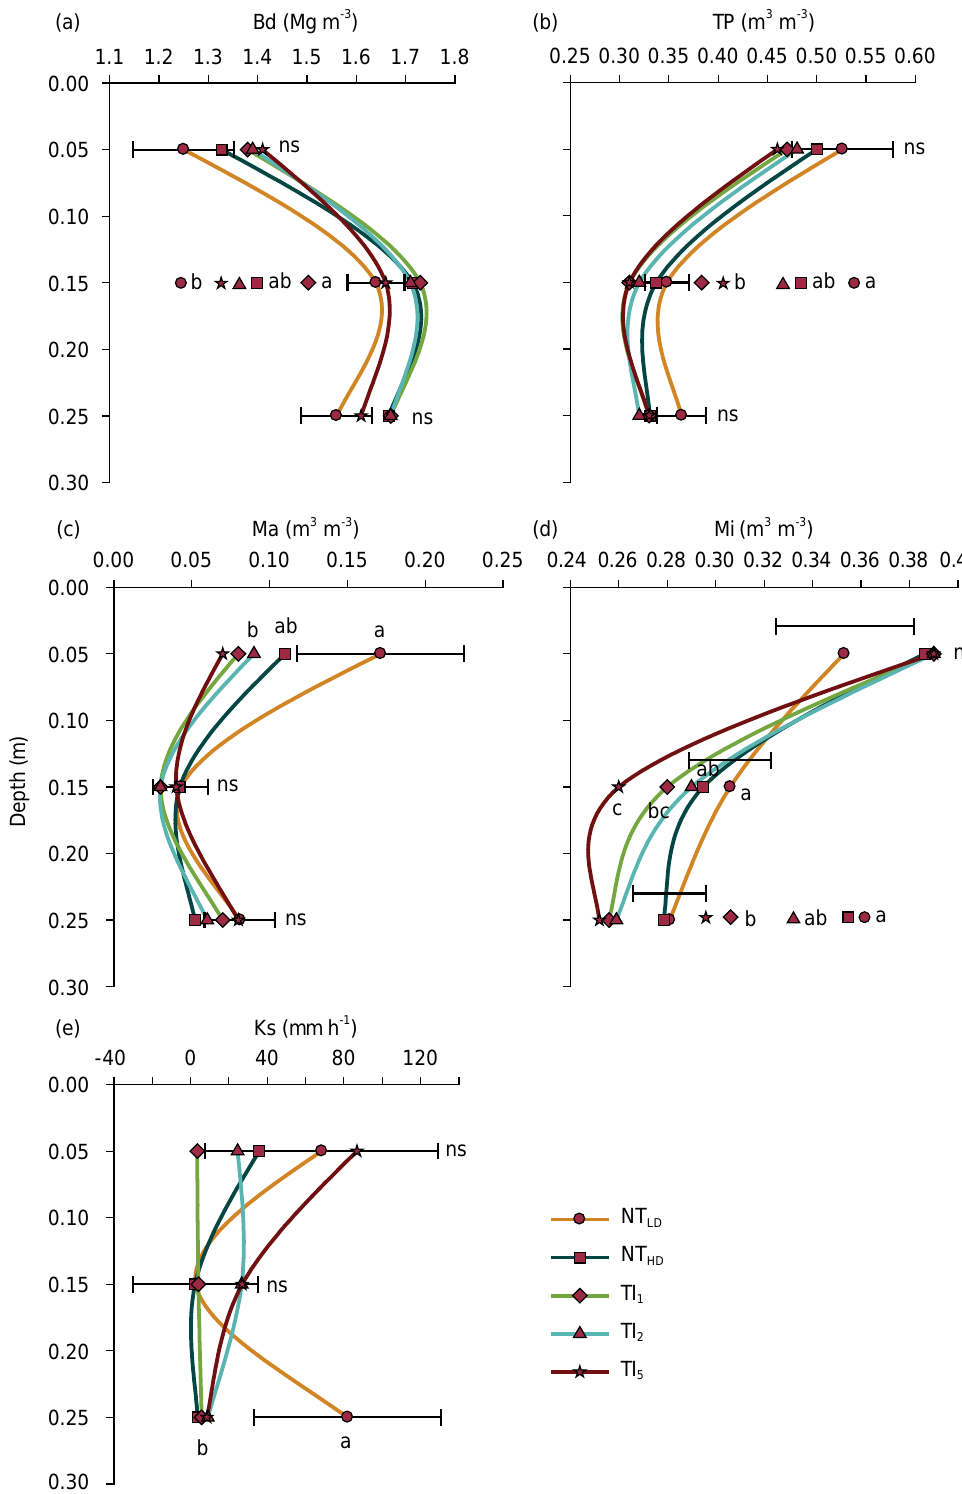
Figure 5. Soil bulk density (Bd) (a), total porosity (TP) (b), macroporosity (Ma) (c), microporosity (Mi) (d), and saturated hydraulic conductivity (Ks) (e) in treatments with no traffic (NT LD and NT HD ) and after 1, 2, and 5 passes (TI 1 , TI 2 , and TI 5 ) of M113 BR in a straight line. Averages followed by the same letter do not differ from each other by Tukey’s test (5 %). ns: not significant by Tukey test (5 %). The horizontal error bars represent the standard deviation of all